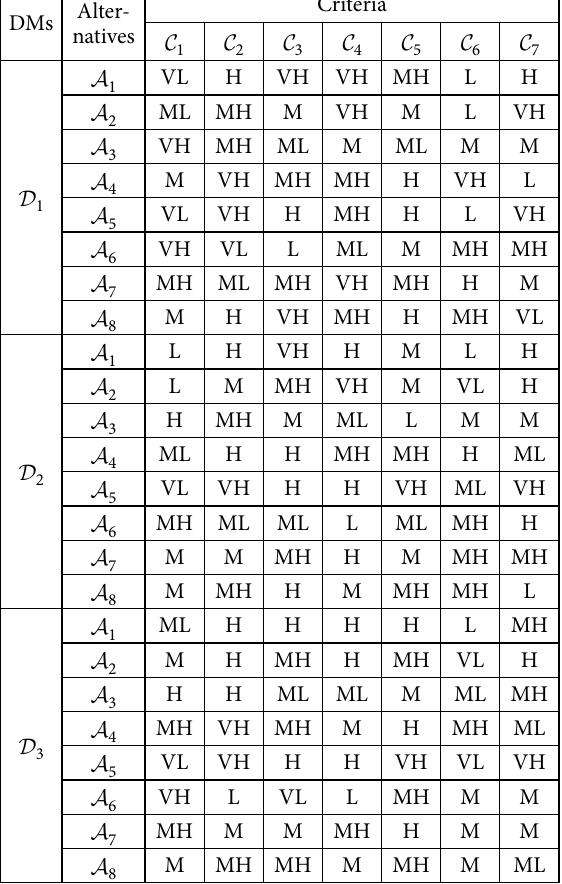
Table 2. Decision matrices of different DMs Alter- DMs